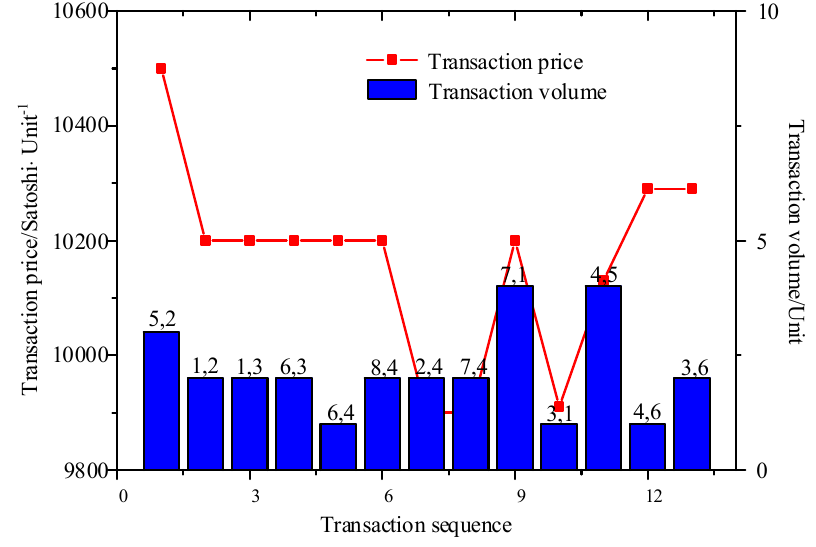
Figure 7. Variation curves of transaction price and volume in a transaction period.